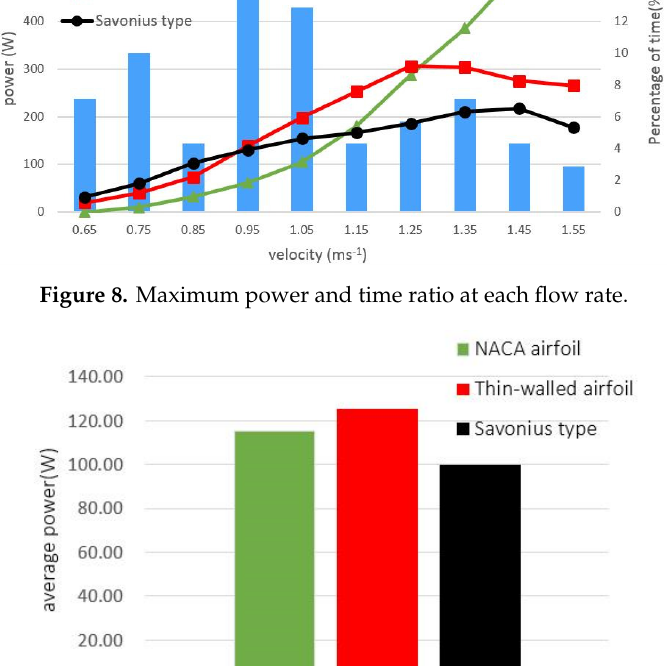
Figure 8. Maximum power and time ratio at each flow rate. Figure 9. Period of average power of three kinds of turbines with time-varying flow velocity.